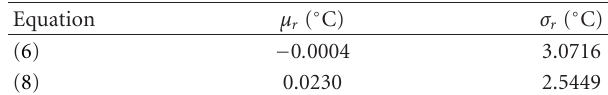
Table 3: Statistics of residuals.